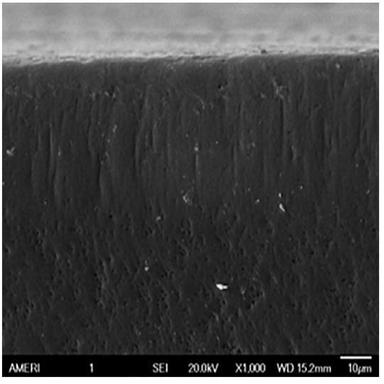
SEM of YSZ side.